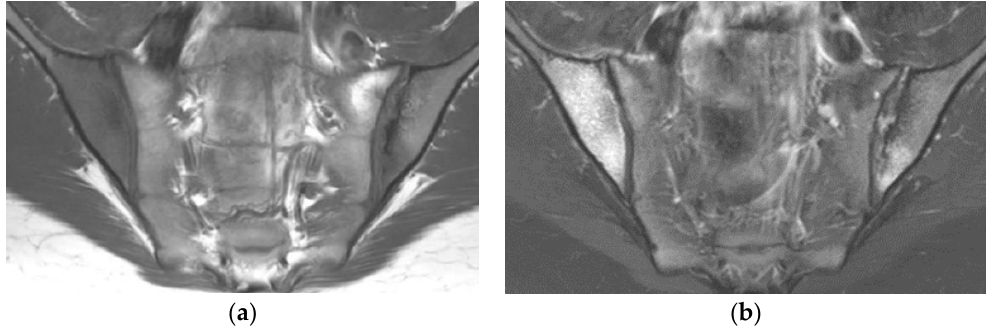
Figure 1. Sacroiliitis with bilateral BME predominating on the right side and erosions, sclerosis, and fat lesion on the left side (coronal oblique T1- ( a ) and fat-suppressed T2- ( b ) weighted images).